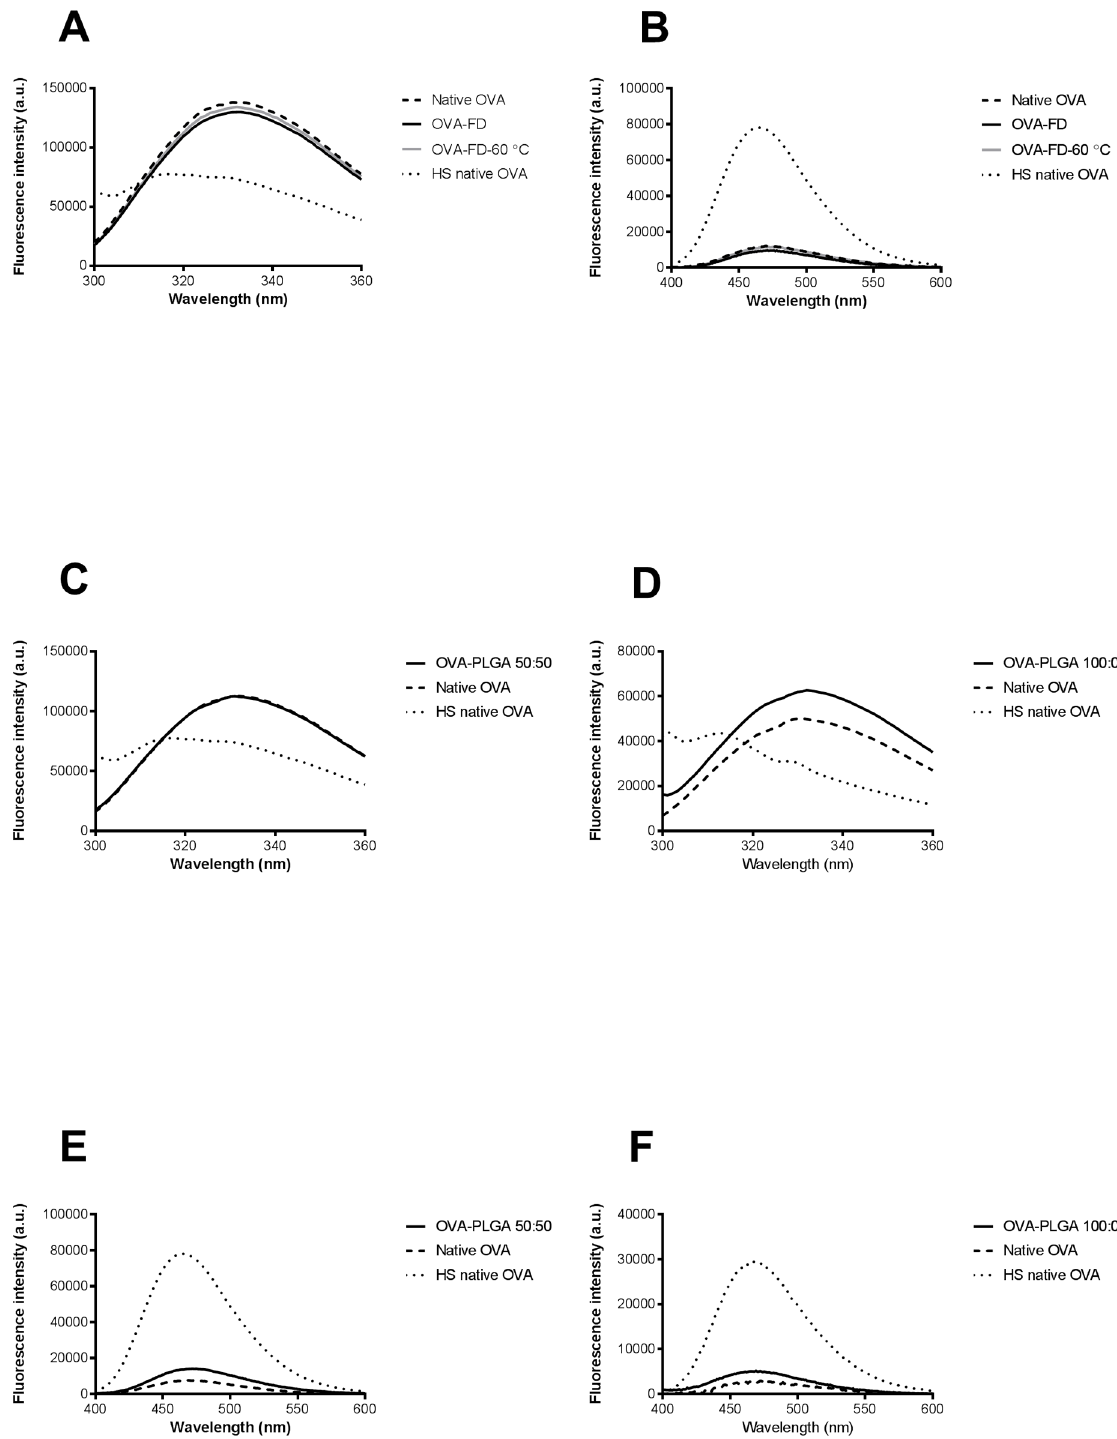
Fig 3. A-F. Intrinsic fluorescence (A) and extrinsic fluorescence (B) of OVA directly after freeze-drying and storage for one week at 60 ˚C. Intrinsic fluorescence of OVA-PLGA 50:50 (C), OVA-PLGA 100:0 (D), extrinsic fluorescence of OVA-PLGA 50:50 (E), and OVA-PLGA 100:0 (F). Native OVA is shown as a dashed line, while HS-OVA is shown as a dotted line.